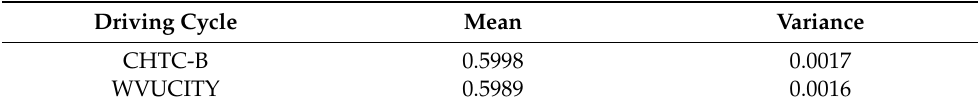
Figure 8. Terminal SOC curves under different driving cycles. ( a ) CHTC-B; ( b ) WVUCITY. Table 3. Statistics of the terminal SOC.